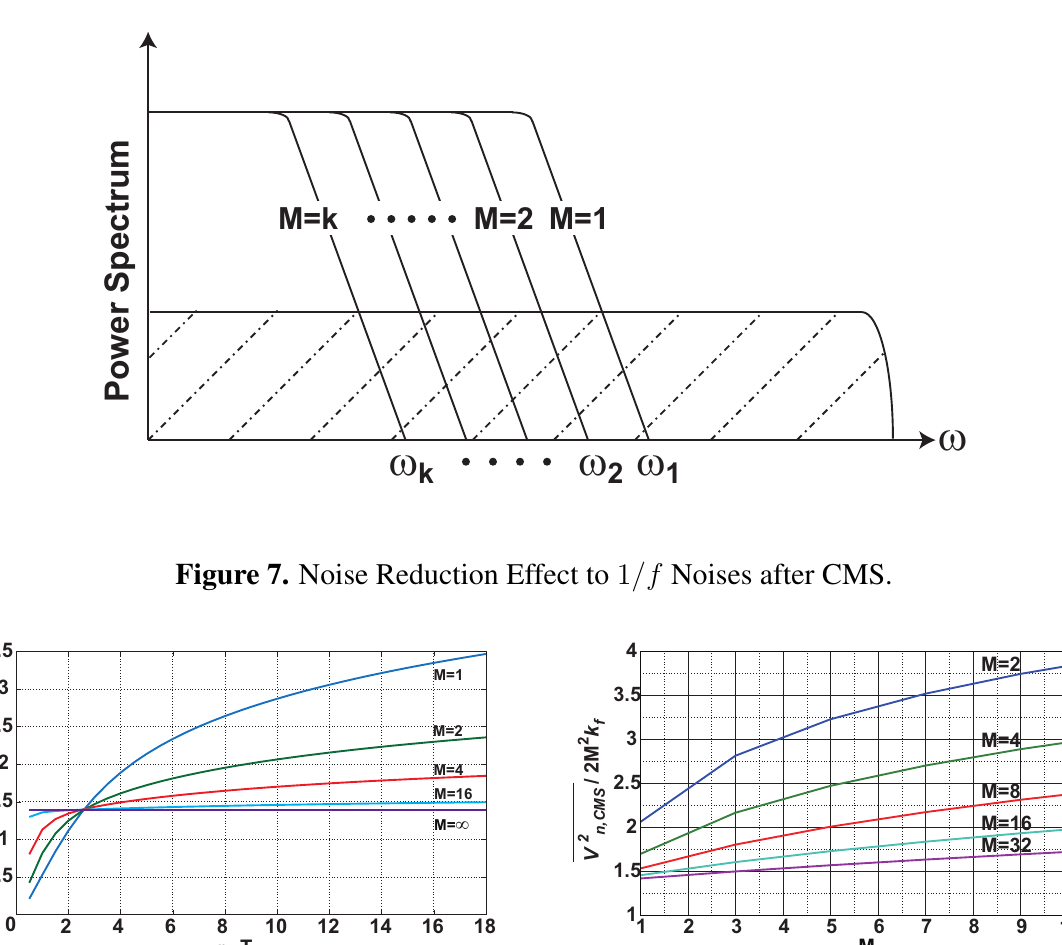
Figure 6. Bandwidth Reduction to Theraml Noise after CMS.